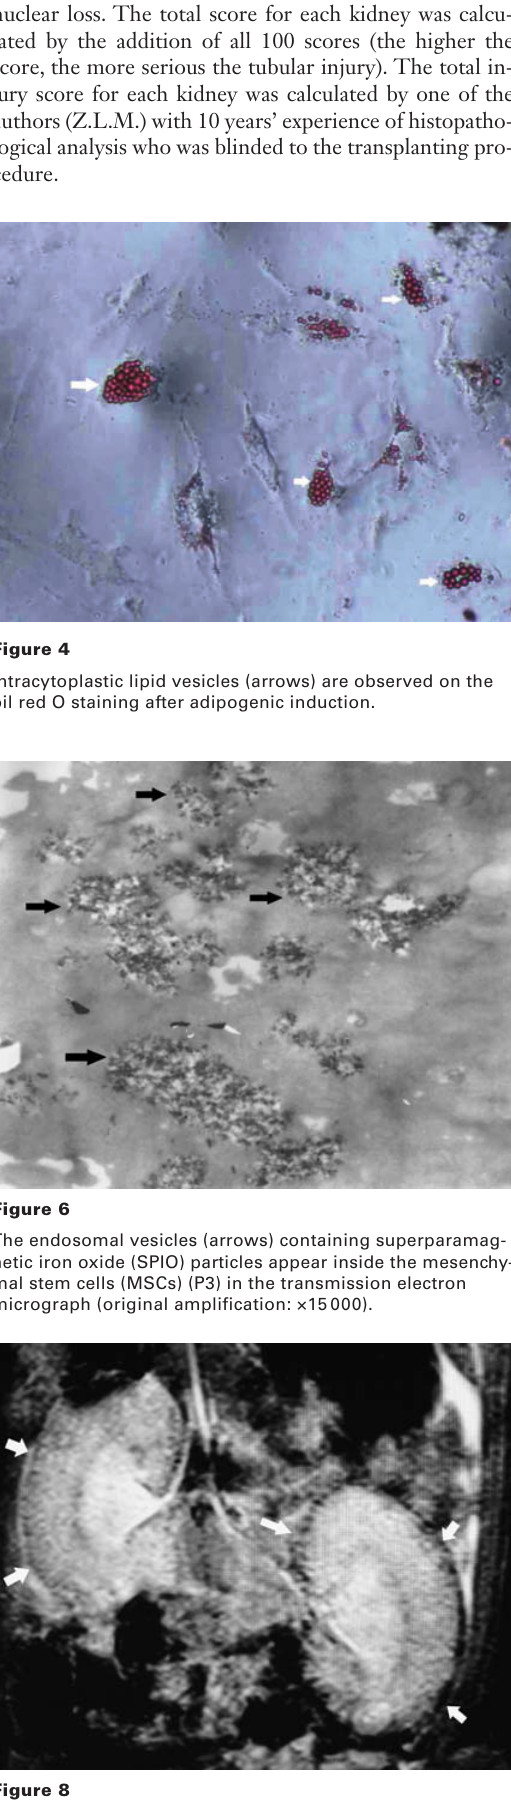
Transverse T2*-weighted MR image of the rat kidney ob- tained before mesenchymal stem cells (MSCs) injection shows mild signal intensity decrease around the renal pelvis (arrows).